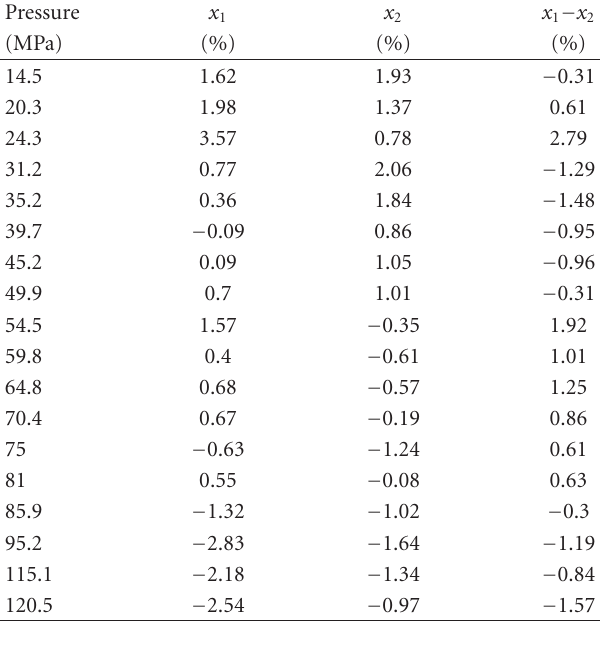
Table 6: Relative errors in calibration coe ffi cients.